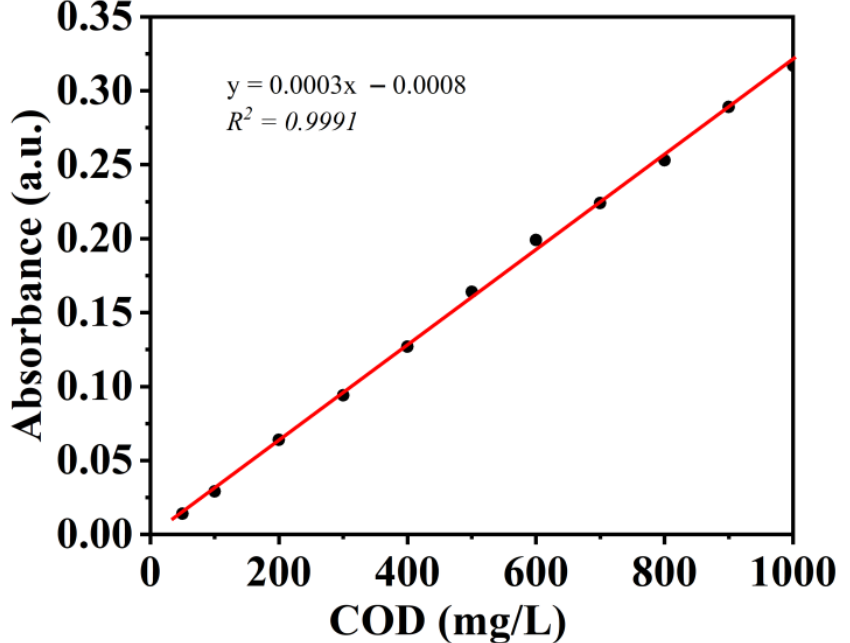
Figure 3. Standard curve for determination of COD index.